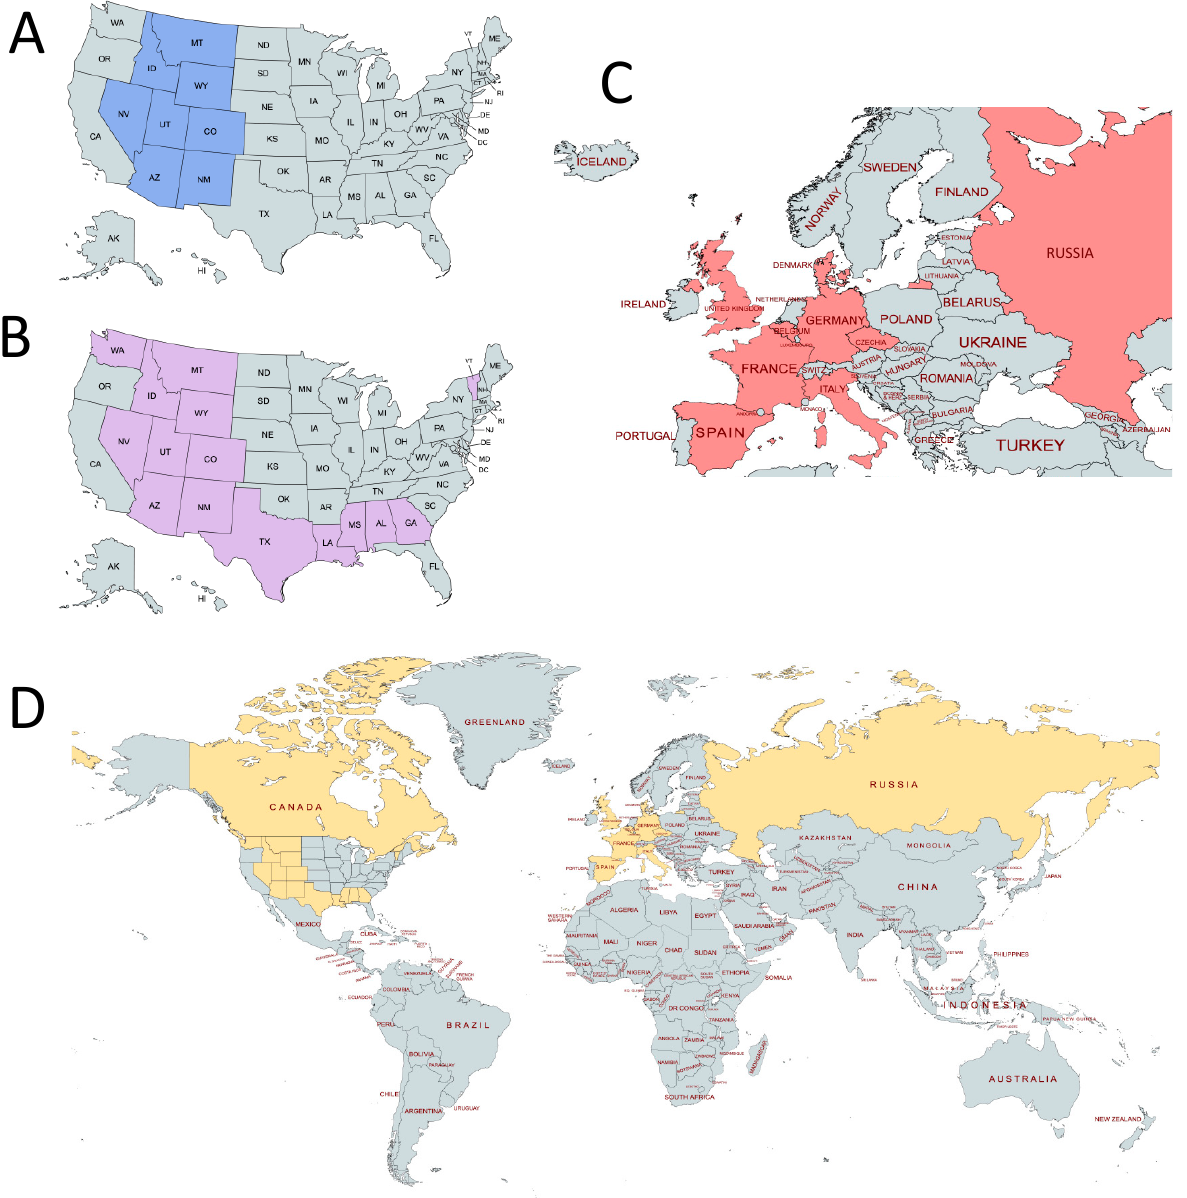
Figure 2. Geographical regions represented by each dataset. ( A ) Mountain West dataset; ( B ) USA dataset; ( C ) European dataset; ( D ) Northern Hemisphere dataset.